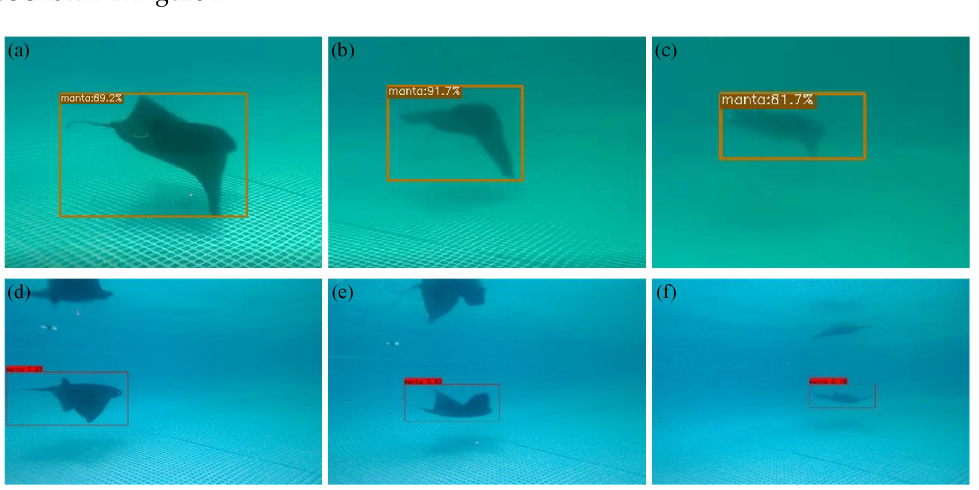
Figure 11. Examples of the object detection results in a small pool ( a – c ) and large pool ( d – f ) at different relative distances: ( a ) 1 m; ( b ) 2 m; ( c ) 3.5 m; ( d ) 1 m; ( e ) 2 m; ( f ) 3.5